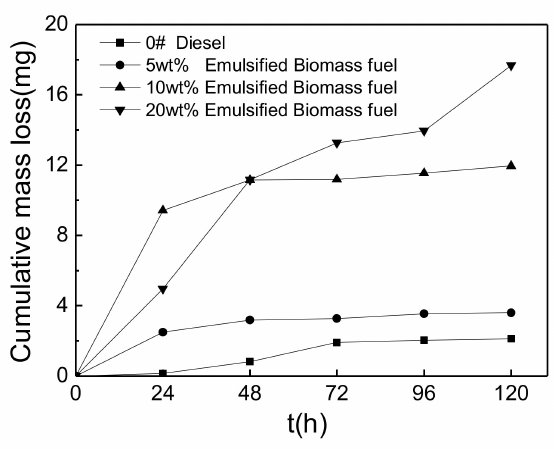
Figure 4. Soaking results of emulsified biomass fuel oil with different